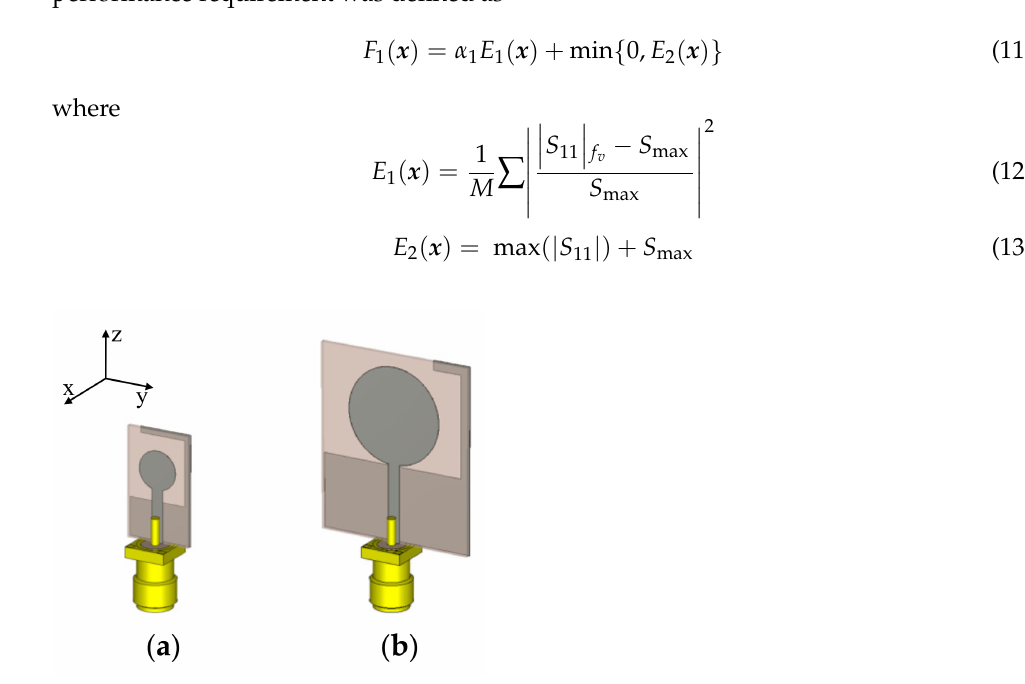
Figure 6. In-scale visualizations of the spline-parameterized antenna at the initial designs ( a ) x 1.1 (0) and ( b ) x 2.1 (0)